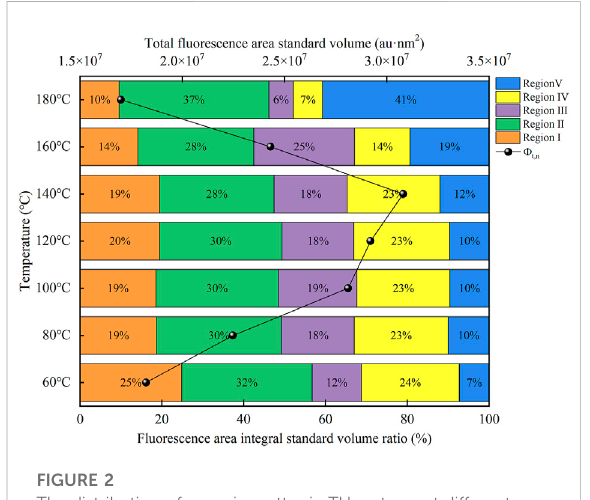
FIGURE 2 The distribution of organic matter in TH systems at different